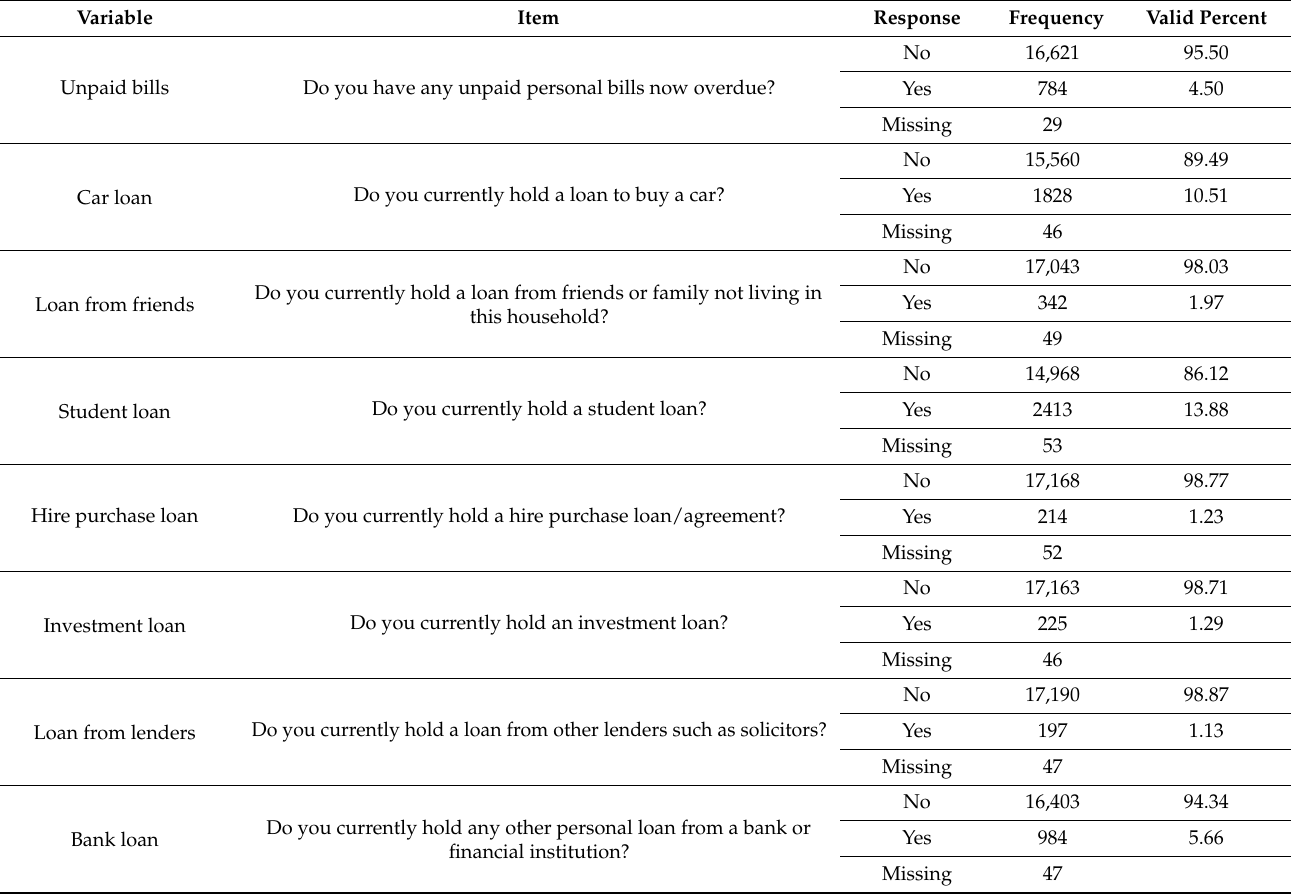
Table 1. Detail of the items relating to debt-taking behaviour (wave